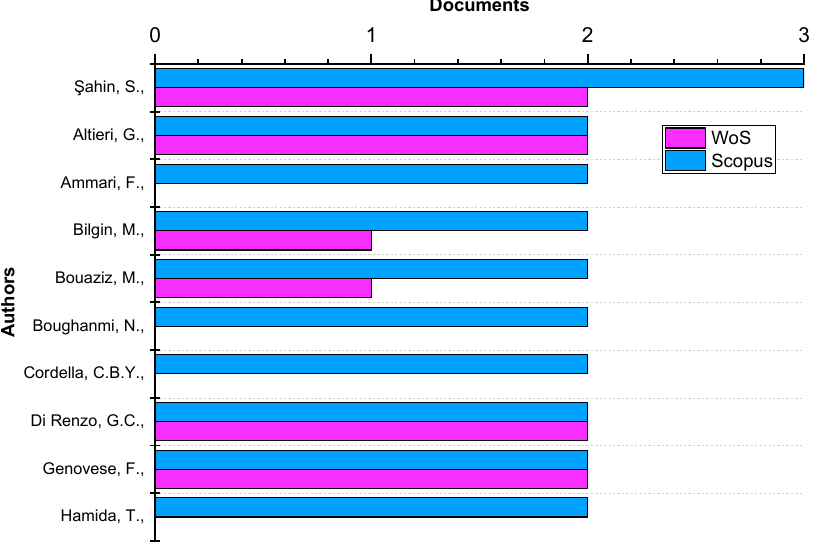
Figure 4. Most productive authors (based on data from Scopus and